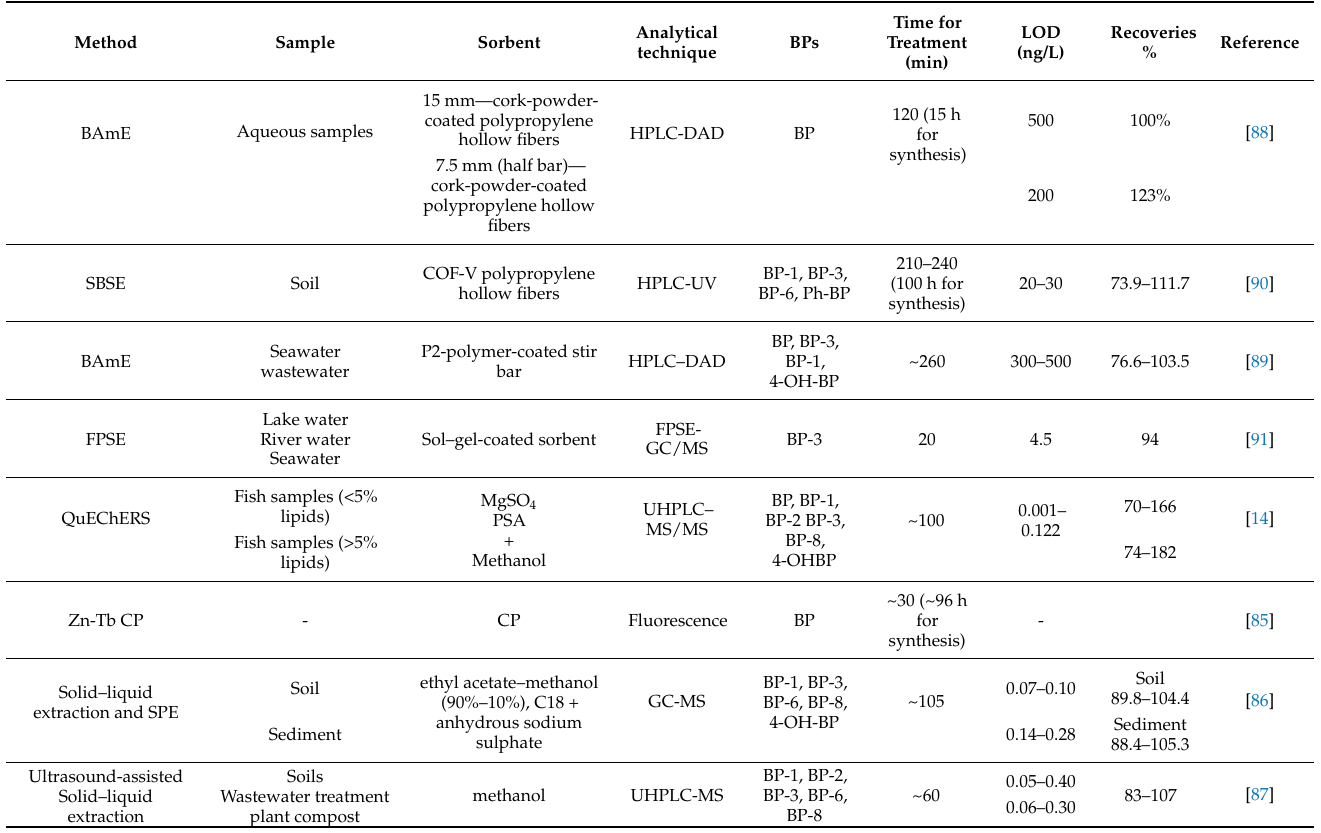
Table 5. Sample pretreatment methods not falling into the pretreatment modes of Tables 2–4 for BP